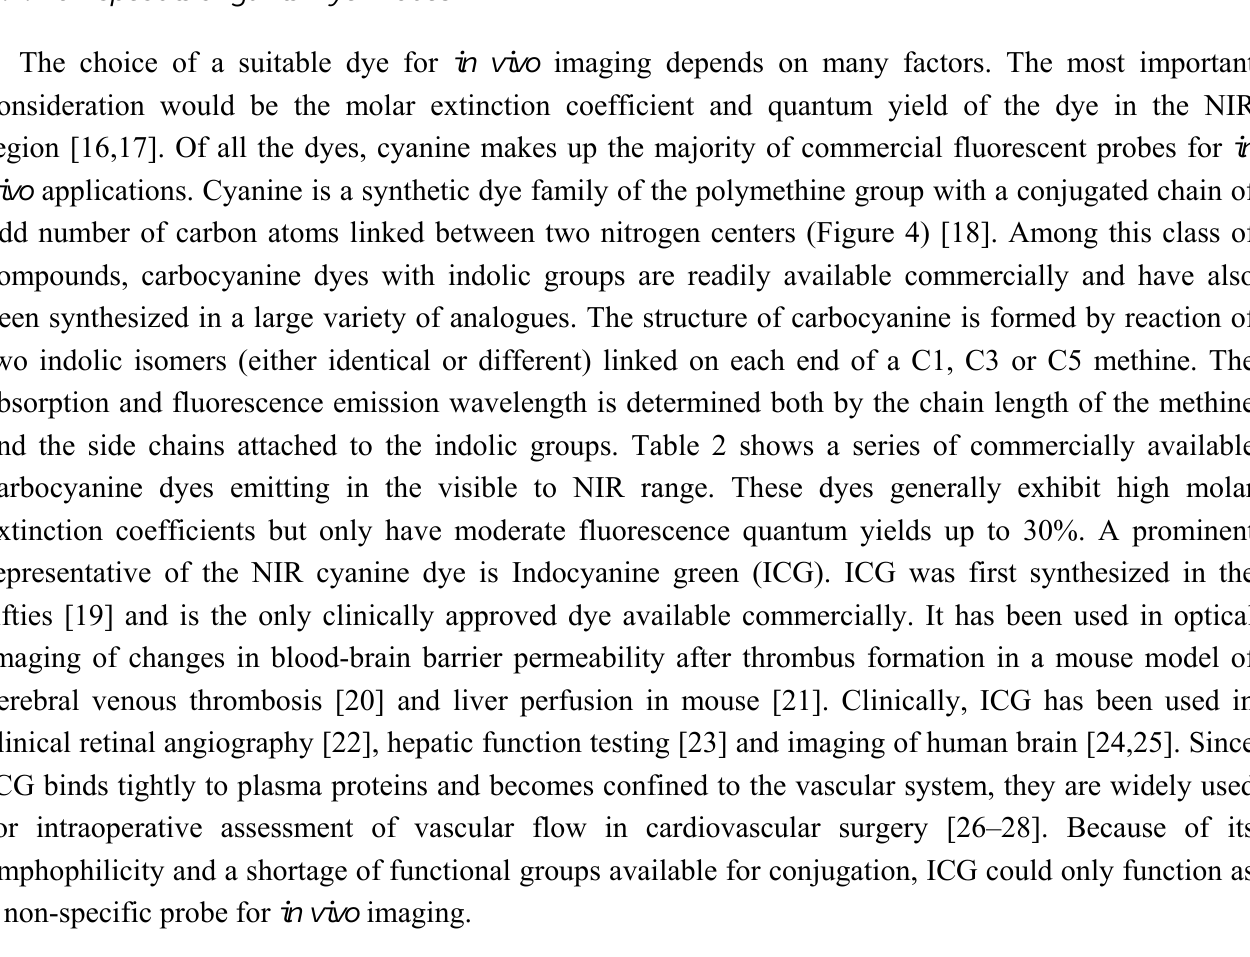
Figure 4. Generalized structure of cyanine dyes. A and A' are two quaternized heteroaromatic